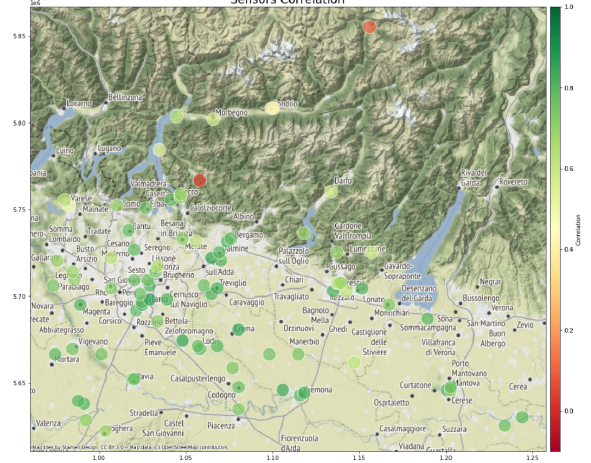
Figure 5 . Map of Pearson’s correlation coefficients computed between the time-series of NO 2 observations from the sensors and the Sentinel-5P at each ARPA Lombardia sensor location in the Lombardy